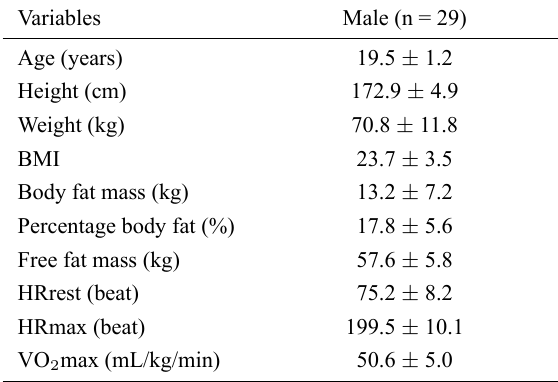
Table 1. Baseline characteristics of the